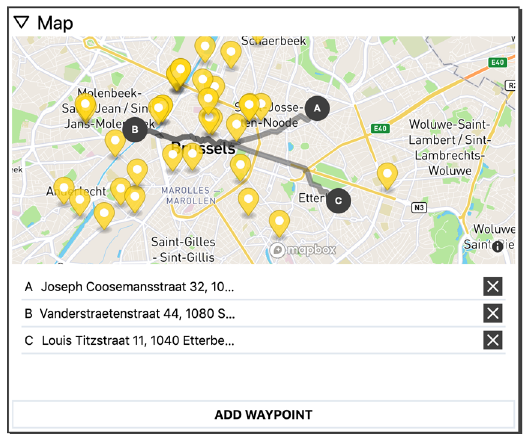
Figure 7. Creation of waypoints.